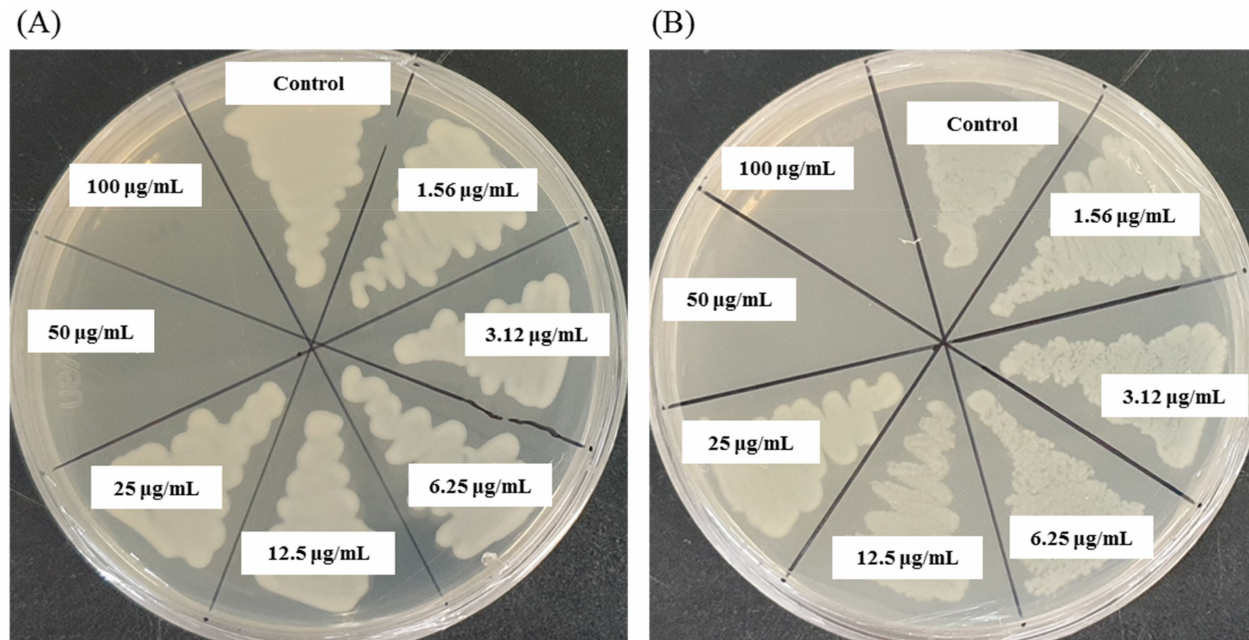
Figure 8. MBC of Massilia sp. MAHUQ-52 mediated synthesized AgNPs against K. pneumoniae ( A ) and S. Enteritidis ( B